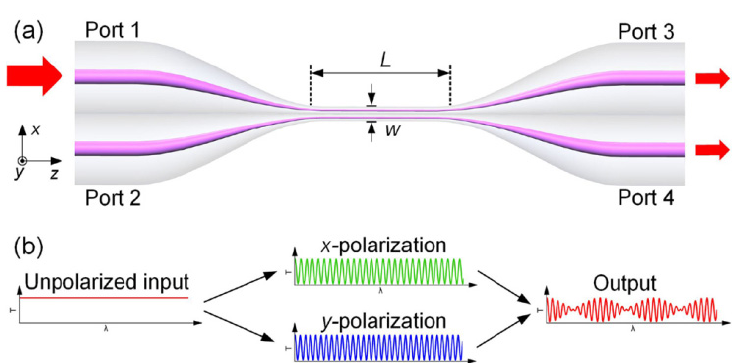
Figure 9. ( a ) Schematic diagram of the OMC. ( b ) Vernier effect operation principle of the OMC [66]. Reprinted with permission from Ref. [66]